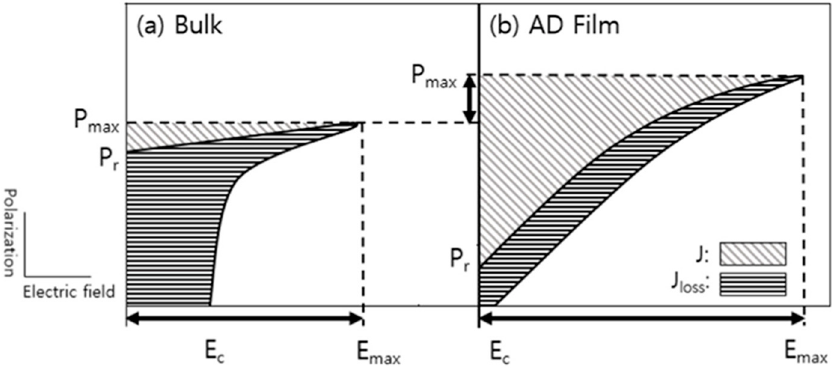
Figure 30. Schematic of comparative P – E loops of ( a ) bulk and ( b ) AD films. ( c ) Variations in energy density and efficiency of 65PMN-35PT films as a function of the electric field [76]. © Copyright 2018, Ceram.